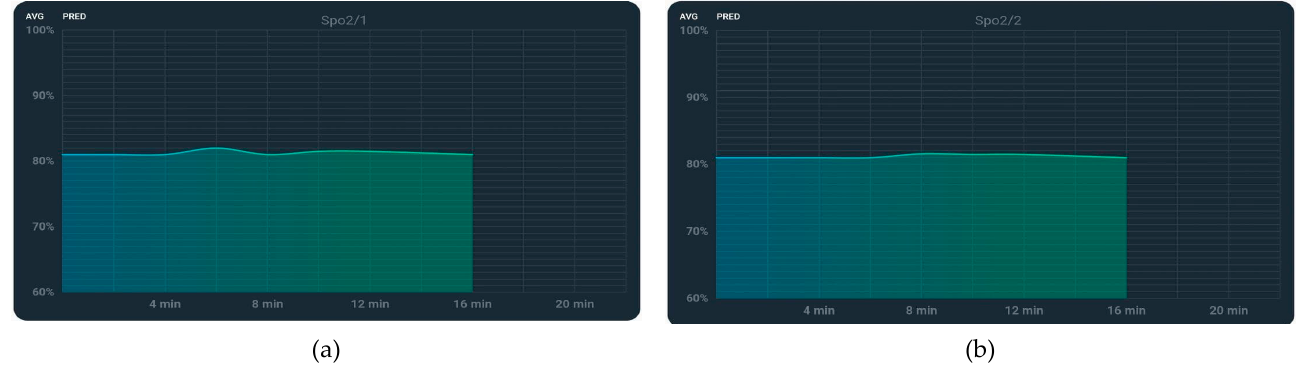
Figure 15. SpO2 measurements: ( a ) from locations B1, and ( b ) from location B2.